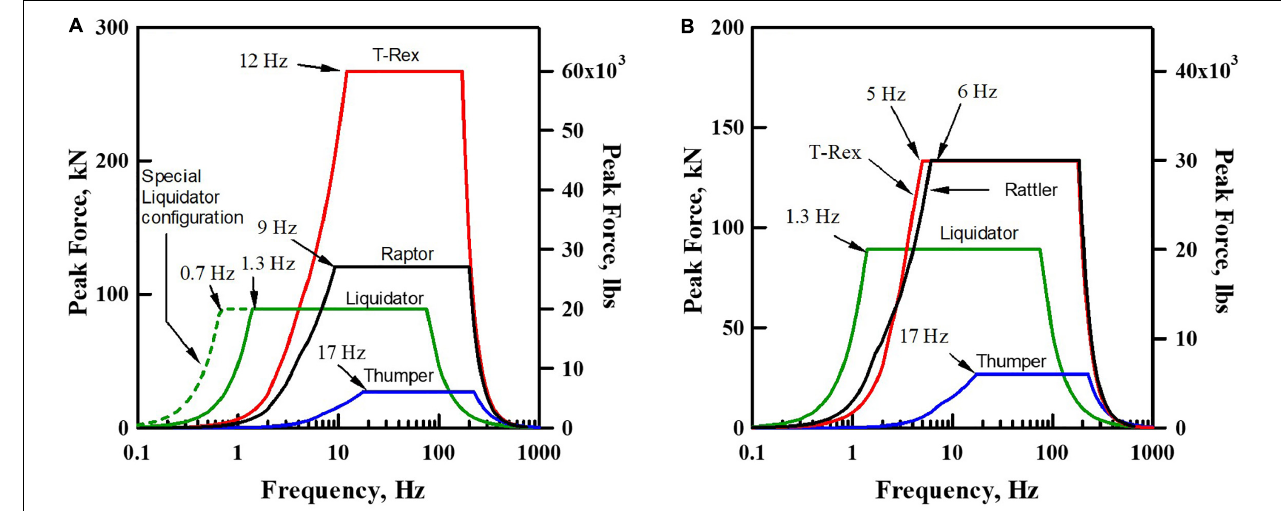
FIGURE 2 | Theoretical force outputs of the five mobile shakers at NHERI@UTexas in the: (A) vertical mode and (B) horizontal mode (Stokoe et al., 2017).